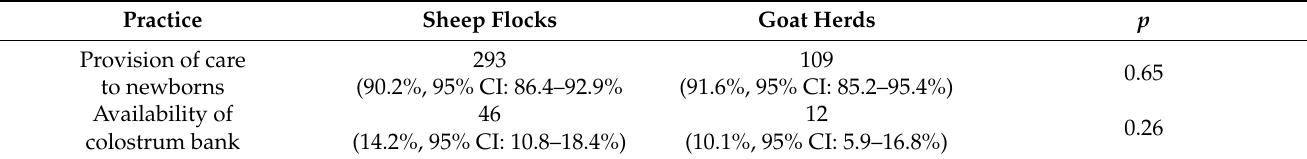
Table 4. Frequency of carrying out various practices related to management of newborns in sheep and goat farms in